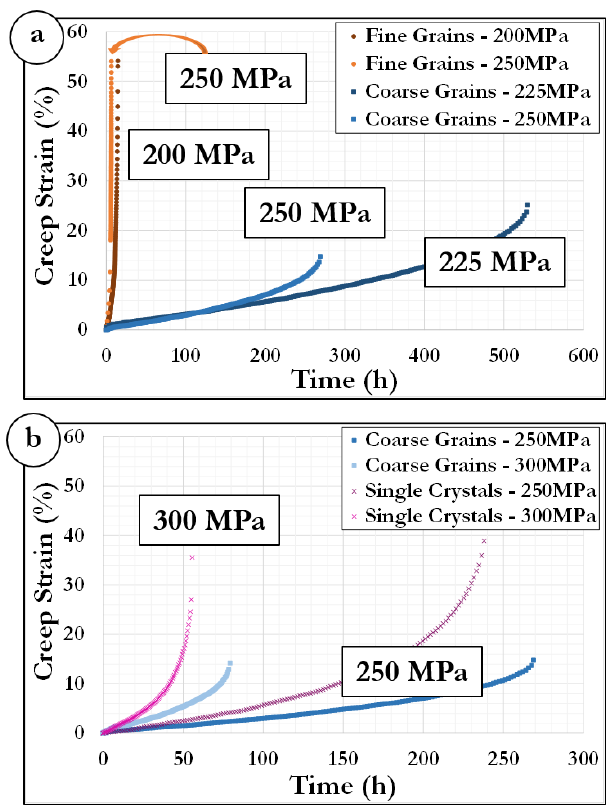
Figure 2. Creep test results at 850 °C: ( a ) Comparison between coarse grains and fine grains, ( b ) Comparison between coarse grains and single